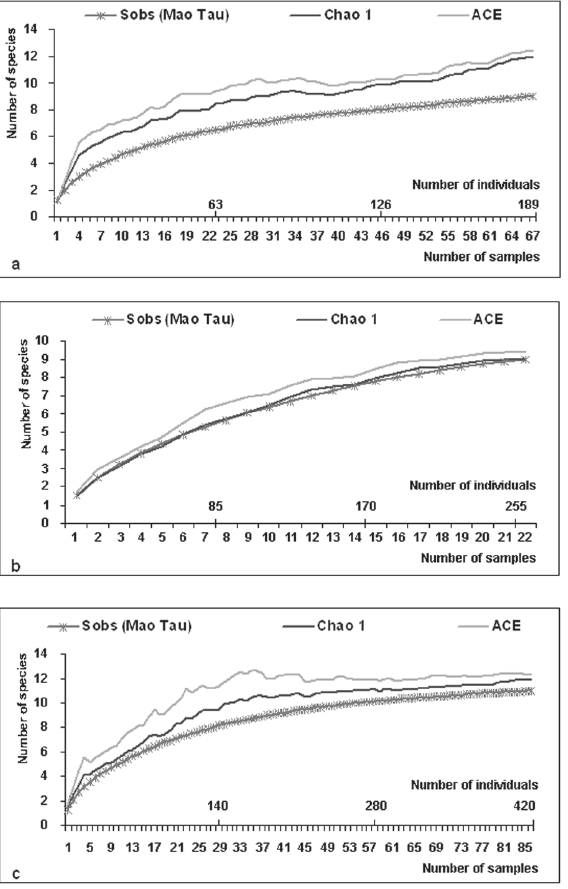
Figure 5 - Comparison of observed and estimated copepod spe- cies richness in different habitats for five caves (UC, VC, LC, CC, DC): a. dripping water (9 species, 67 samples); b. associ- ated pools (9 species, 22 samples); c. dripping water and associ- ated pools (11 species, 87 samples).